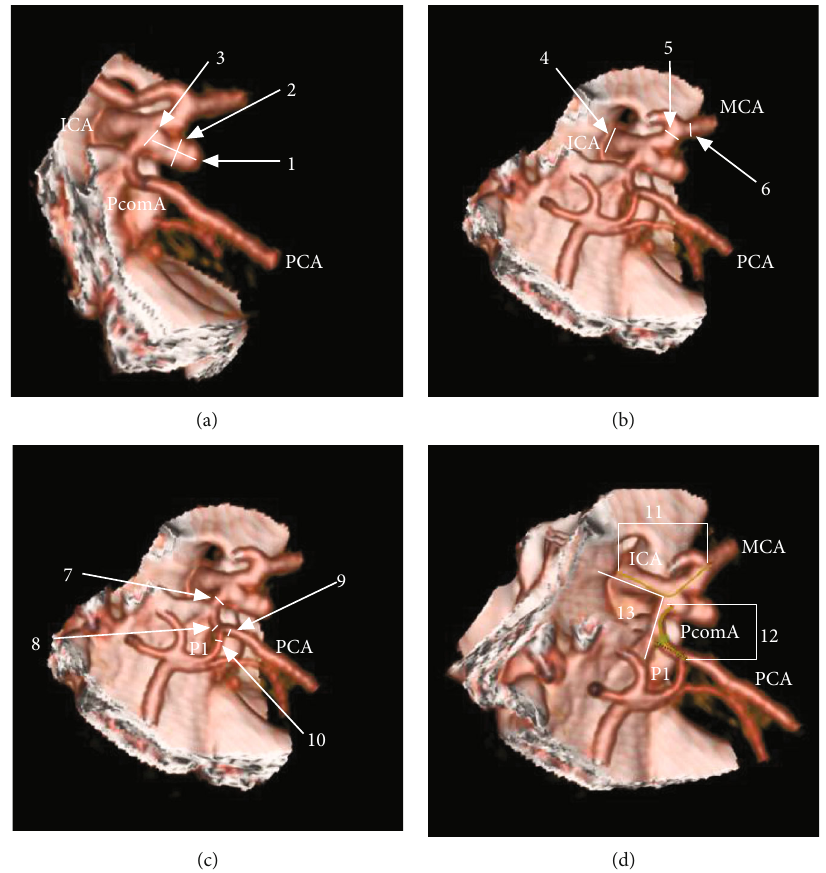
Figure 2: CTA-based measurement parameters are as follows: (a) No. 1 is the height of the aneurysm, No. 2 is the width of the aneurysm, and No. 3 is the width of the aneurysmal neck; (b) No. 4 is the diameter of the intradural ICA at its origin, No. 5 is the diameter of the ICA at its termination, and No. 6 is the diameter of the MCA at its origin; (c) No. 7 is the diameter of the PcomA at its origin, No. 8 is the diameter of the PcomA at its termination, No. 9 is the diameter of P2 at its origin, and No. 10 is the diameter of P1 at its termination; (d) No. 11 is the length of the intradural ICA, No. 12 is the length of the PcomA, and No. 13 is the angle between the ICA and the PcomA. Abbreviations: CTA: computed tomography angiography; ICA: internal carotid artery; MCA: middle cerebral artery; PCA: posterior cerebral artery; PcomA: posterior communicating artery; P1: fi rst segment of